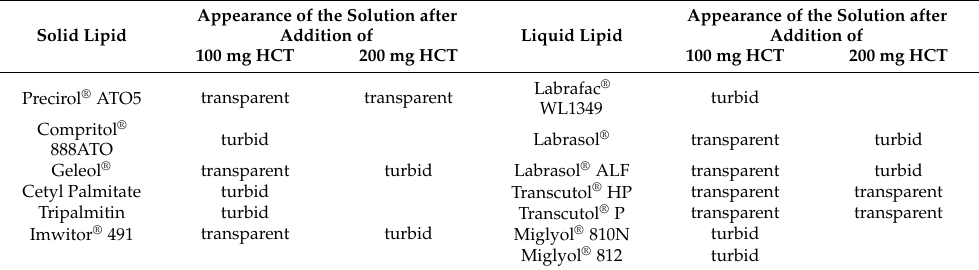
Table 1. HCT solubility in melted solid lipids (65 ◦ C), and in liquid lipids heated at 65 ◦ C in terms of solution transparency or turbidity (100 or 200 mg drug added to 5 g of melted solid lipid or 5 mL of liquid